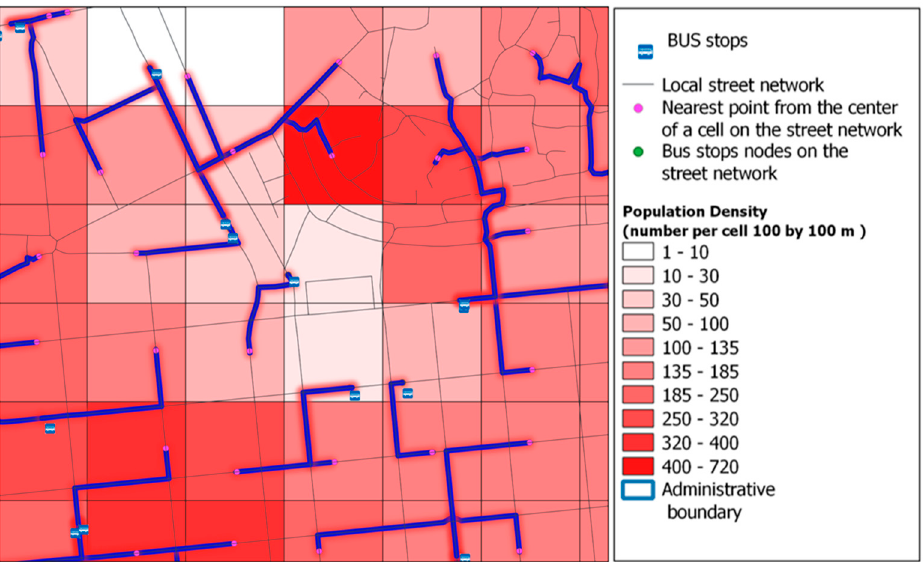
Figure 9. Graphical representation of SDG 11.2.1. computation step 4. The walkable paths from starting to ending points are shown in blue.